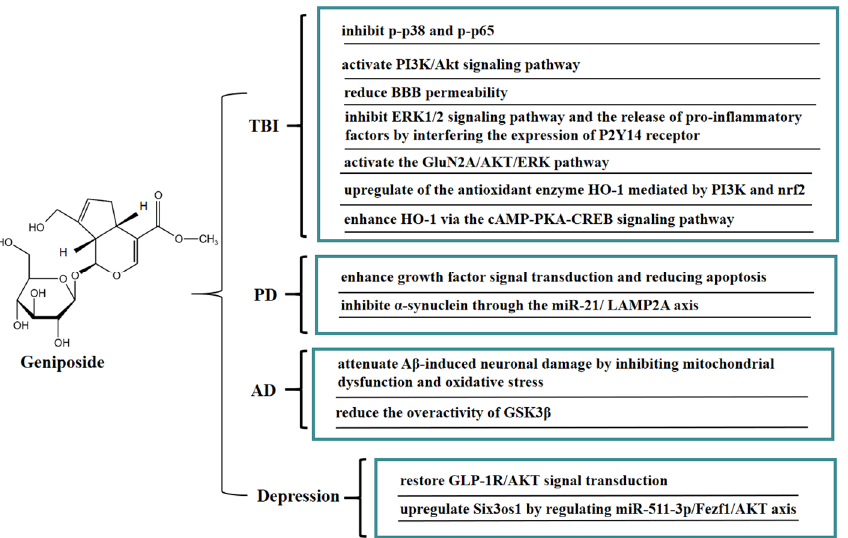
Figure 7. A summary of mechanisms of geniposide on neurological